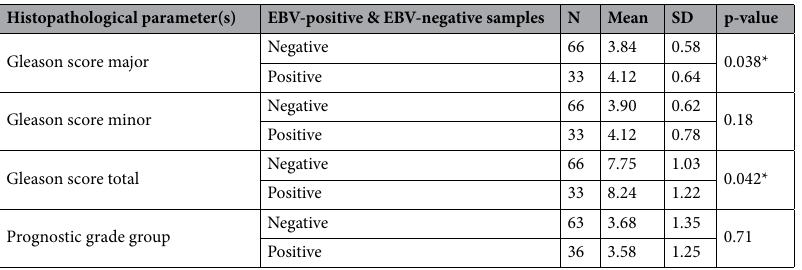
Table 2. Comparison of mean Gleason scores of EBV-positive and EBV-negative groups using independent samples t-test. The table shows the mean score comparison of Gleason major, Gleason minor, and total Gleason scores in between positive and negative samples. The histopathological analysis of tumor tissues was done as per the International Society of Urological Pathology (ISUP) 2014 and later ratified by WHO 2016 as the prostate cancer grade group system. *p < 0.05 was considered significant using an independent sample